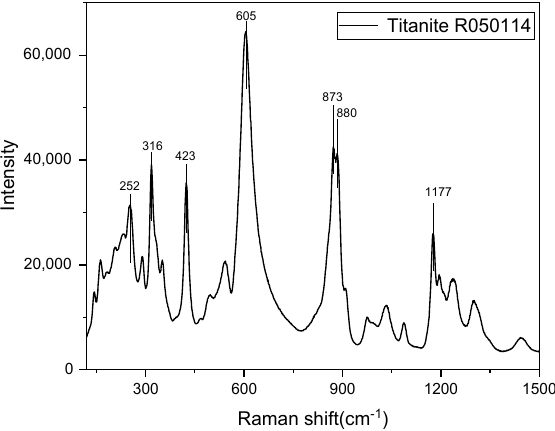
Figure 12. Raman spectrum of titanite R050114 from RRUFF database.